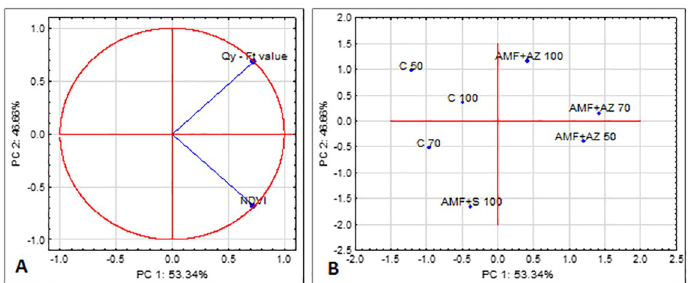
Fig 4. Bi-plot presenting the correlation between the tested fluorescence parameters of tomato transplant leaves (A) and ordination illustrating differences between substrates tested towards the fluorescence parameters of tomato transplant leaves (B). C 50 –peat:sand ratio 50:50 (v:v) without inoculation; C 70 –peat:sand ratio 70:30 (v:v) without inoculation; C 100 –peat:sand ratio 100:0 (v:v) without inoculation; AMF + AZ 50 –peat:sand ratio 50:50 (v:v) inoculated with arbuscular mycorrhizal fungi (AMF) and Azospirillum brasilense (AZ), AMF + AZ 70 –peat:sand ratio 70:30 (v:v) inoculated with AMF and AZ, AMF + AZ 100 –peat:sand ratio 100:0 (v:v) inoculated with AMF and AZ; AMF + S– 100 peat:sand ratio 100:0 (v:v) inoculated with AMF and Saccharothrix tamanrassetensis (S).